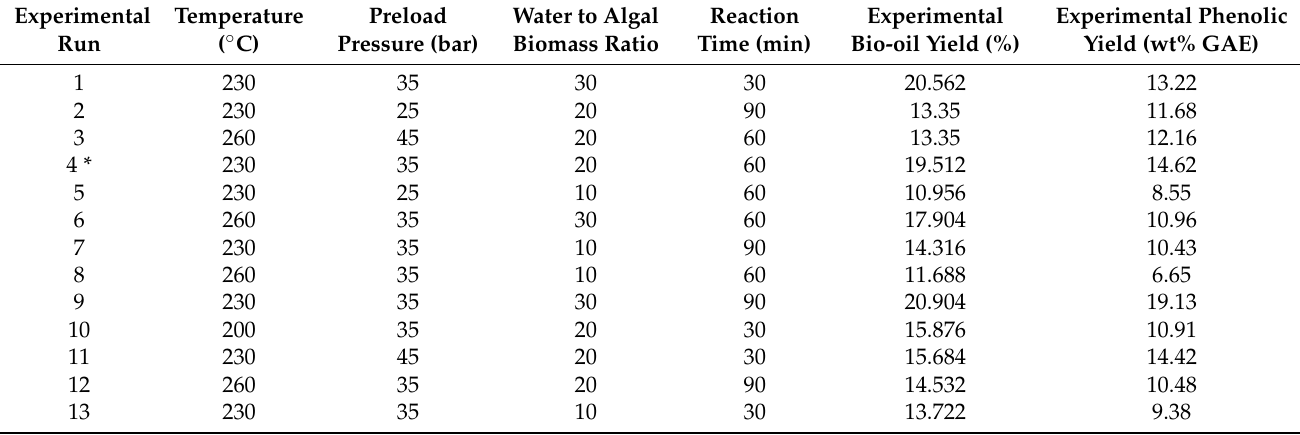
Table 3. Experimental results for optimization